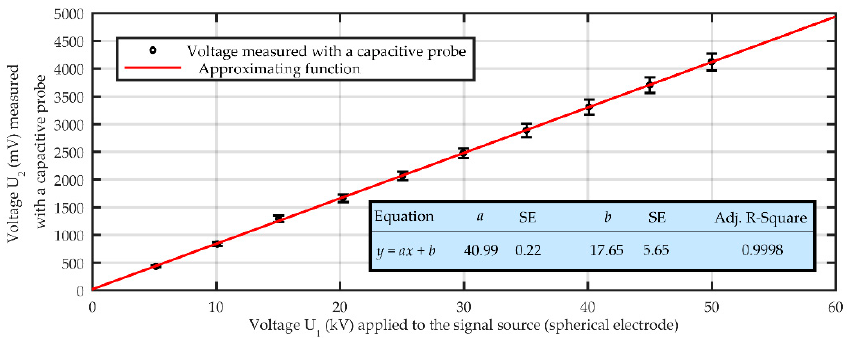
Figure 14. Linear relationship between the voltage U 2 measured with the capacitive probe and the actual value of the voltage U 1 present on the tested HV object.